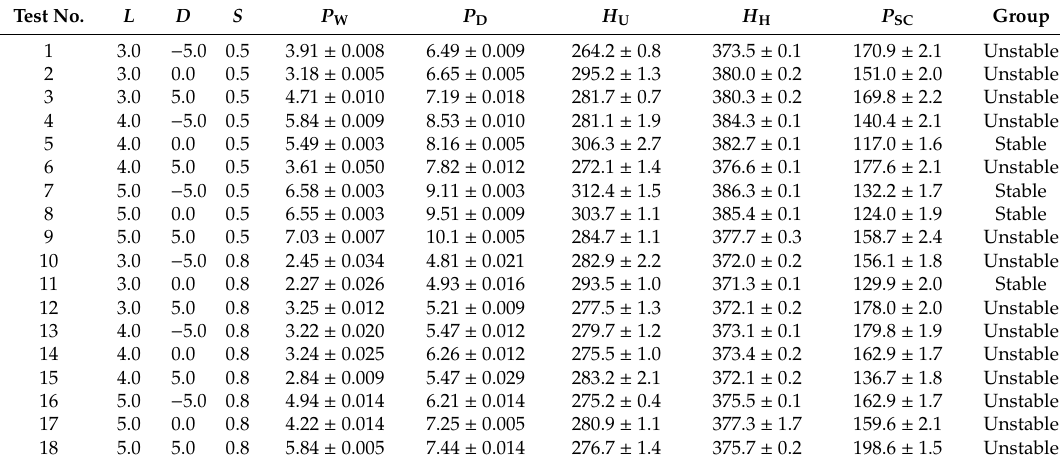
Table 9. Learning data for discriminant of fiber laser welding quality.